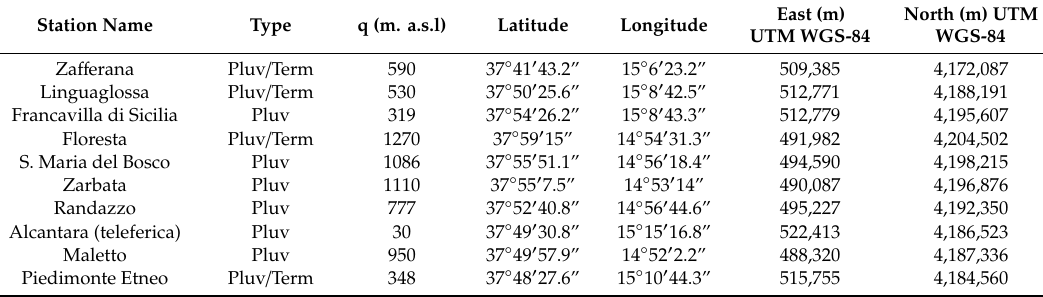
Table 3. Weather stations within and nearby the Alcantara at Moio river basin.